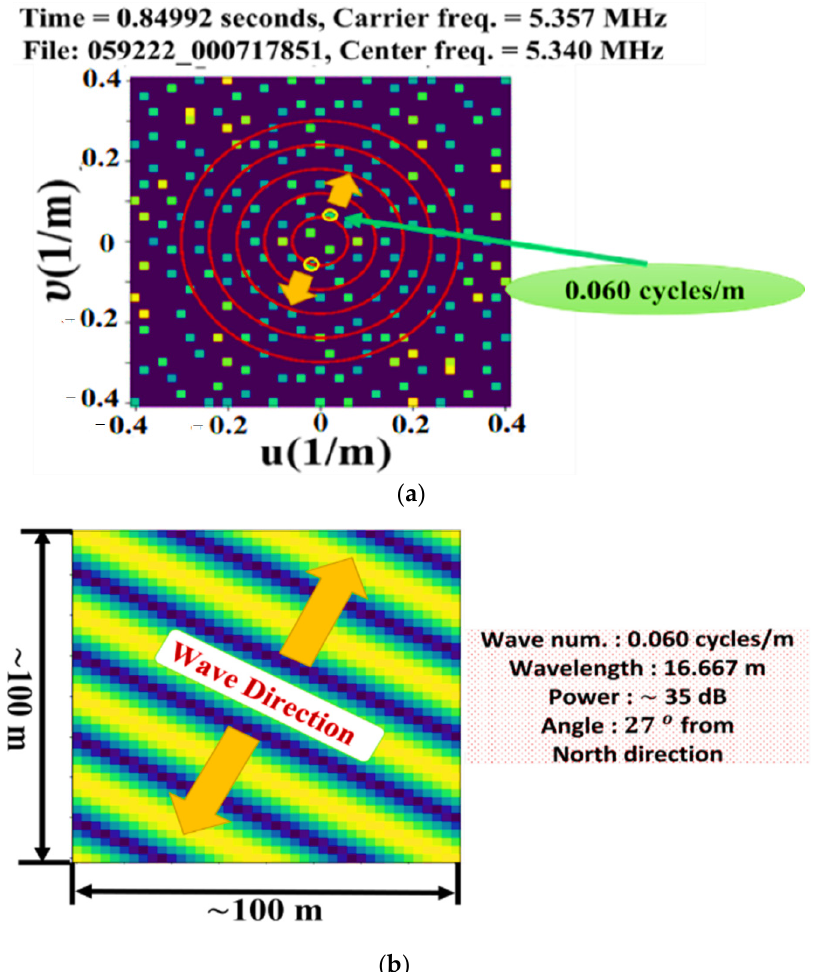
Figure 12. ( a ) A Fourier image demonstrating the wave direction (0.06 cycles/m) (yellow circle) of LWA-1 pointing northeast–southwest with an angle about 30 degrees from the north–south direction. ( b ) IFT of the spatial frequency with its wave vector.